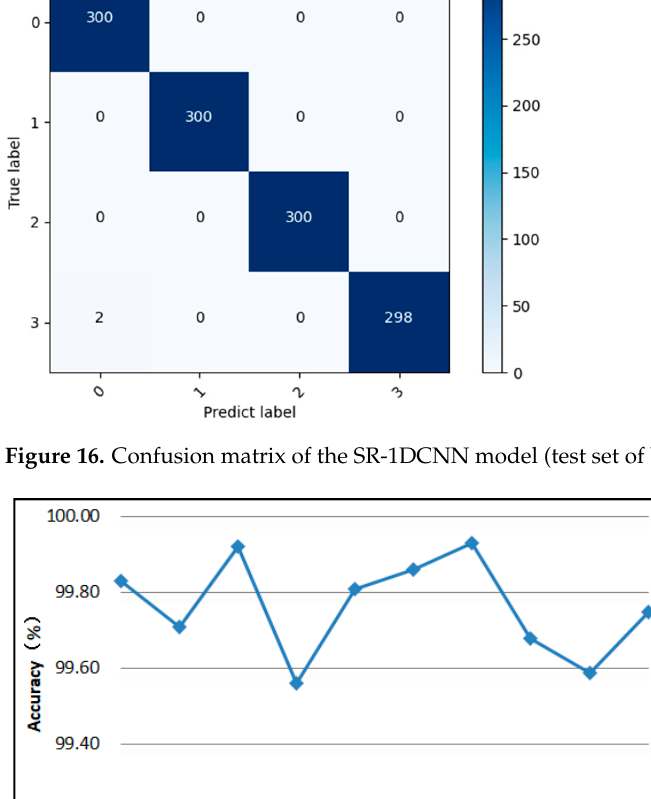
Figure 16. Confusion matrix of the SR-1DCNN model (test set of Worm Gear Reducer).